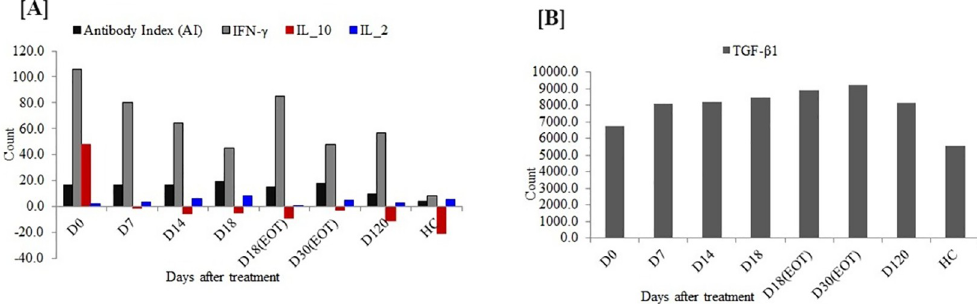
Fig 2. Antibody Index, IFN- γ , IL-10, IL-2, and TGF- β 1 serum concentrations in VL patients before, during, and after treatment cf. concentrations in healthy